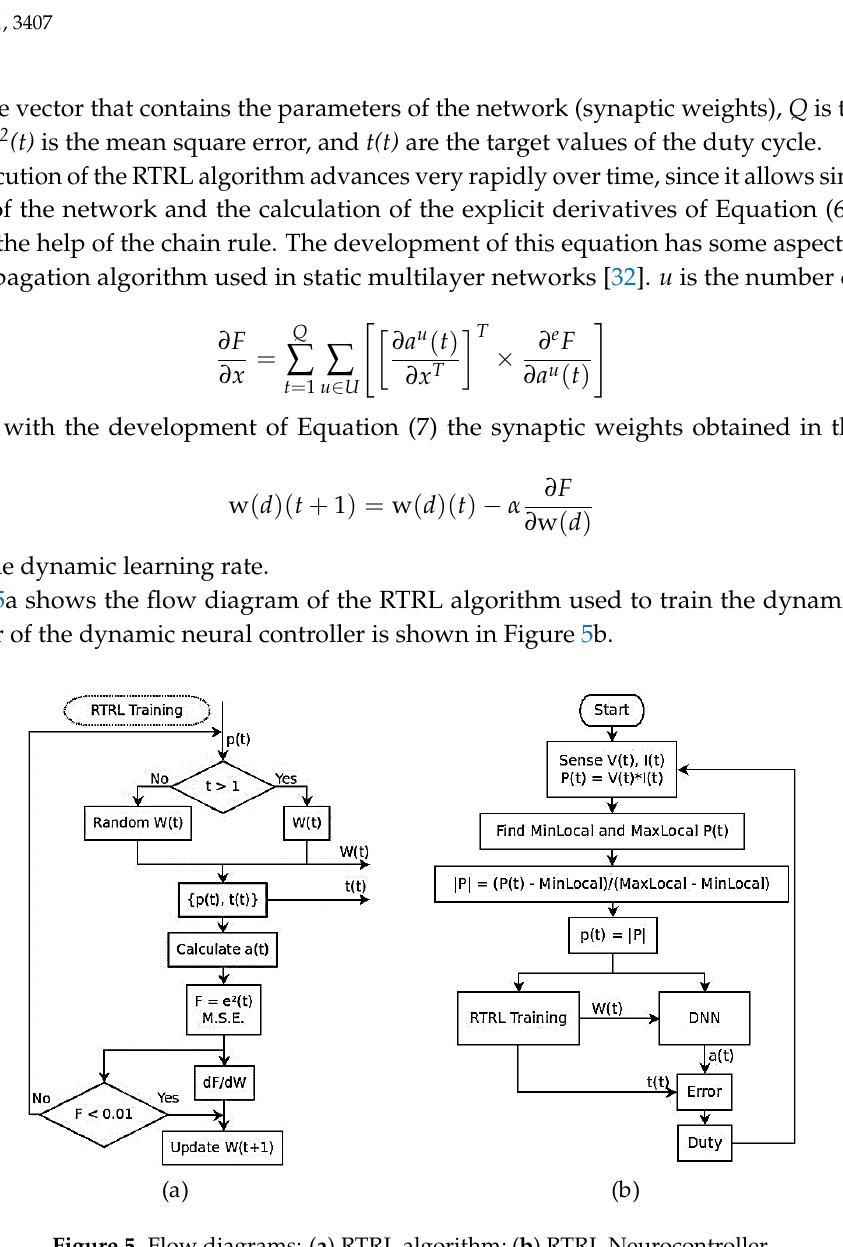
Figure 5. Flow diagrams: ( a ) RTRL algorithm; ( b ) RTRL Neurocontroller.